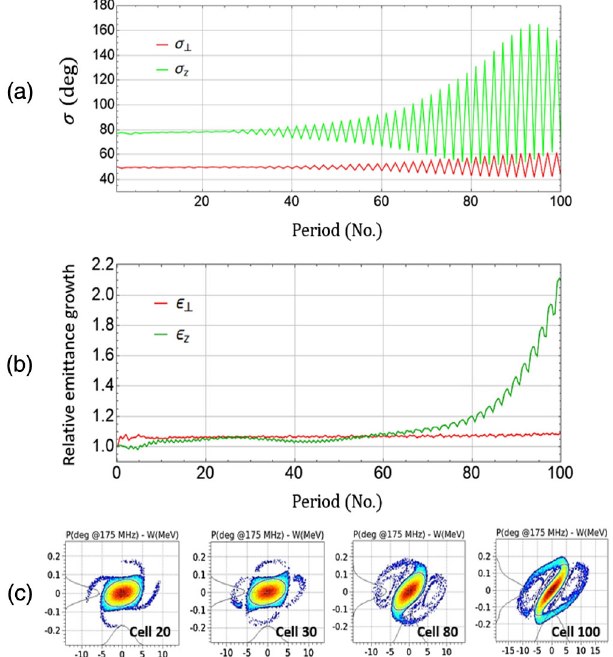
FIG. 9. (a) Depressed phase advances and (b) relative emittance growth under the solenoid focusing lattice without acceleration. The longitudinal phase advances are σ z 0 ¼ 100 ° and σ z ¼ 77 °, at which the beam remains within the fourth-order particle reso- nance stop band. Fourth-order resonance is predominantly manifested over 40 periods, drawing four separate islands on (c) the phase (deg) vs energy (MeV) planes. Envelope instability occurs as σ z increases to over 90°, accompanied by large emittance growth (green lines).